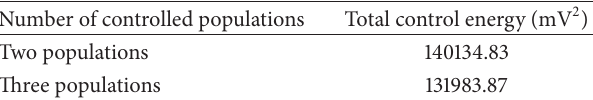
Table 2: The total control energy over 20 simulation realizations for the model containing two hyperexcitable